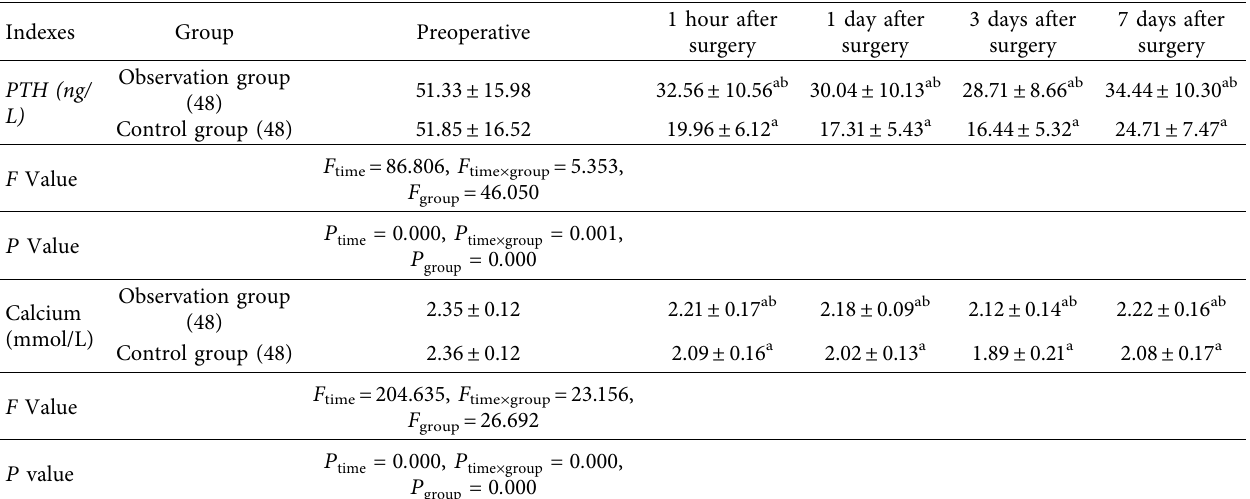
Compared with preoperative in this group, a P < 0.05. Table 4: Comparison of serum PTH and calcium between two groups at different time points ( x ± s ).